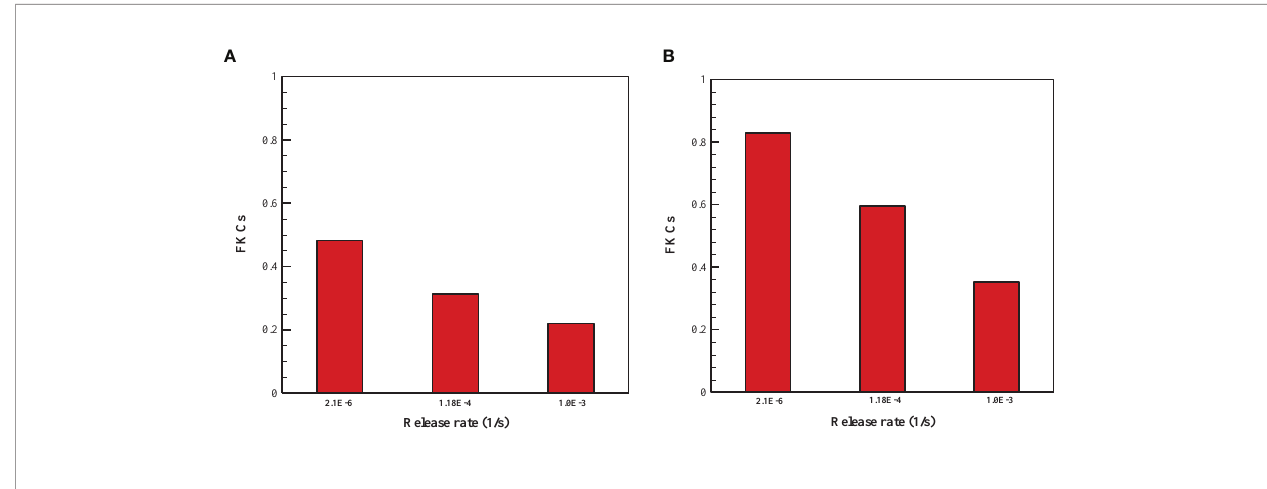
FIGURE 8 | Comparison of treatment ef fi cacy of two NP sizes for different release rates. K ON was set to 15[m 3 /[(mol.s)] in all cases. (A) 100 nm, (B) 20